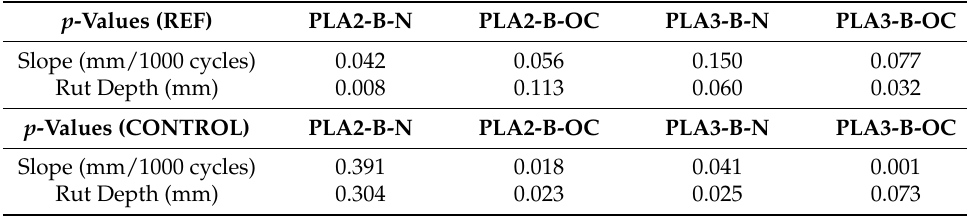
Table 11. p -values of rutting results.